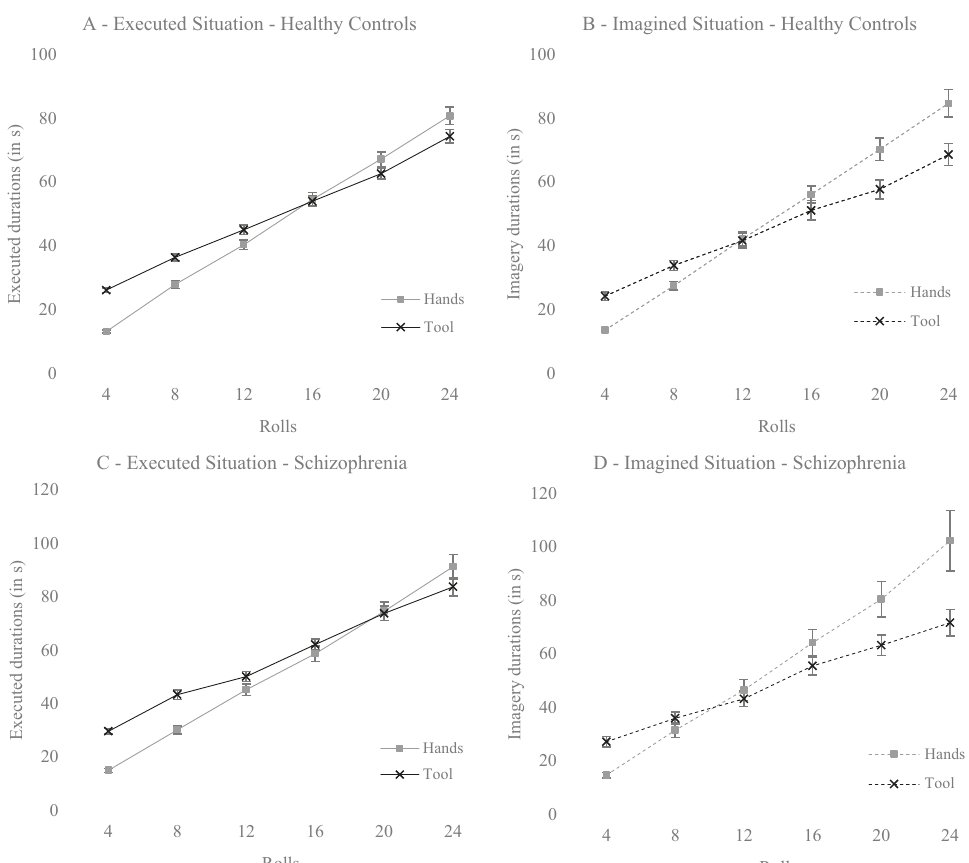
Fig. 1 Movement durations as a function of rolls, conditions, situations, and groups. A Durations in real situation as a function of rolls and conditions in healthy control group. B Durations in imagined situation as a function of rolls and conditions in healthy control group. C Durations in real situation as a function of rolls and conditions in schizophrenia group. D Durations in imagined situation as a function of rolls and conditions in schizophrenia group (hands are represented by gray squares, tool by black crosses, and error bars correspond to standard